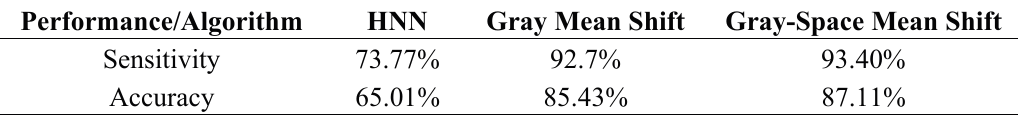
Table 2. Performance of the nucleus segmentation